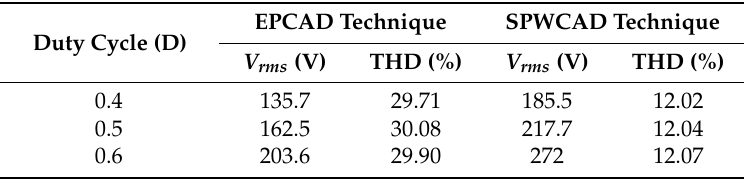
Table 7. Simulation comparison of ( V rms ) and % THD.